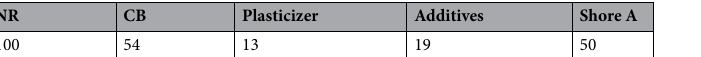
experimental measurements. Further, it is not an easy task to obtain the exact unloading rate of region B during crack growth. Therefore, the unloading rate effect on the recovered elastic energy will be investigated. The unloading rate can directly be estimated from the experimentally measured crack growth rate. Thus, denoting the time taken by the crack to grow an increment (cid:31) a by t c , the average unloading rate due crack growth is determined as